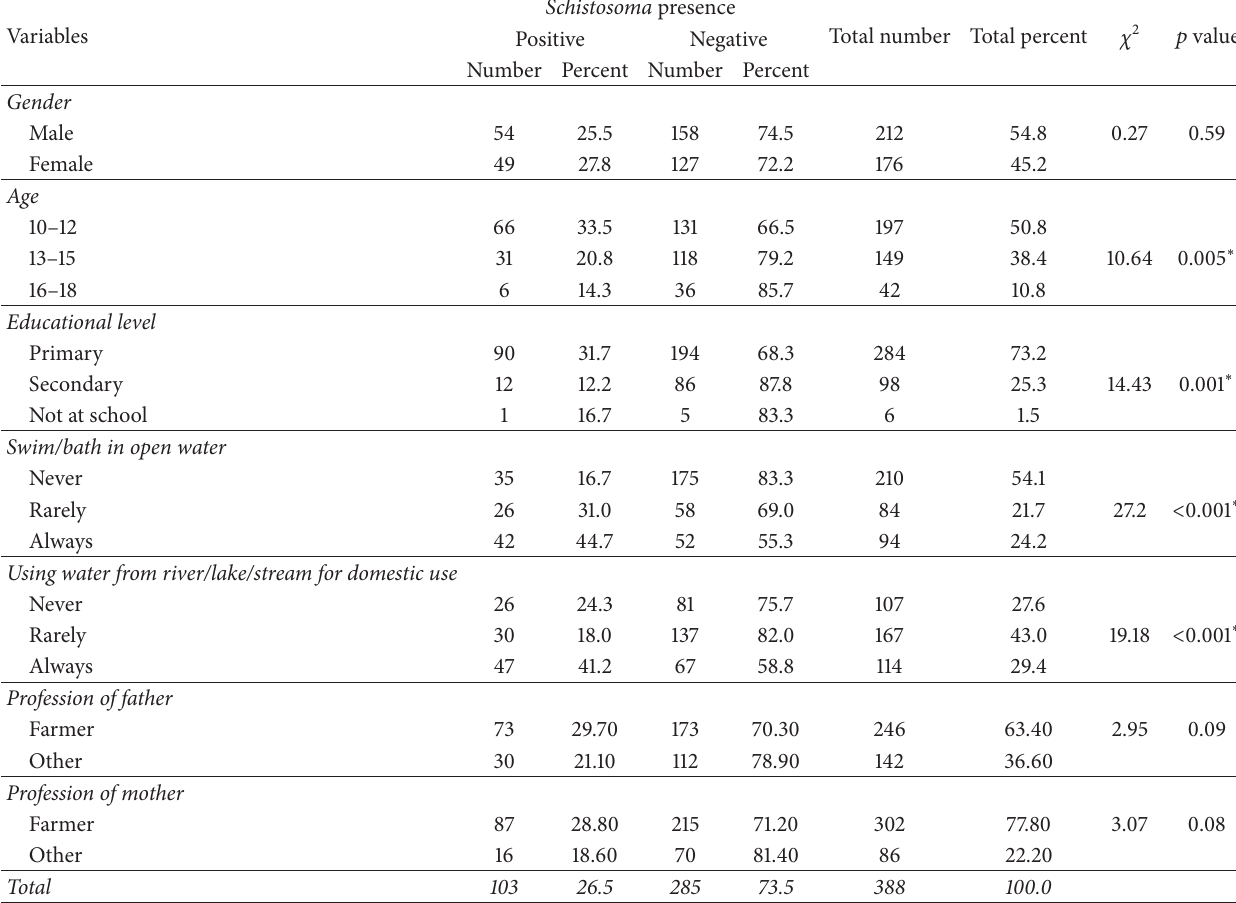
Table 1: Schistosoma mansoni infection and associated factors in the four health areas of Kisantu health zone.